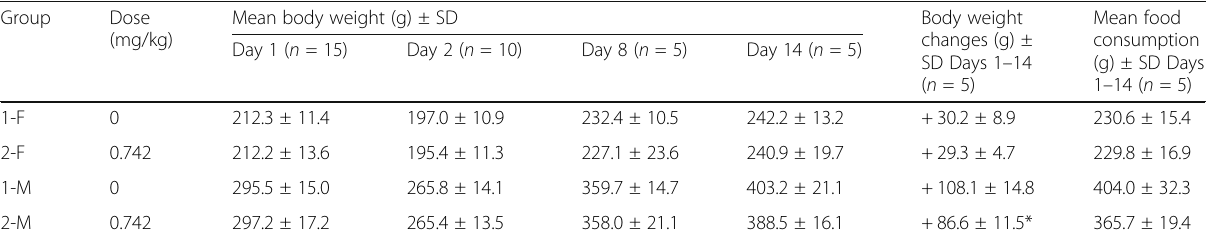
Table 2 Summary of body weights, body weight changes, and food consumption during 14-day treatment-free recovery